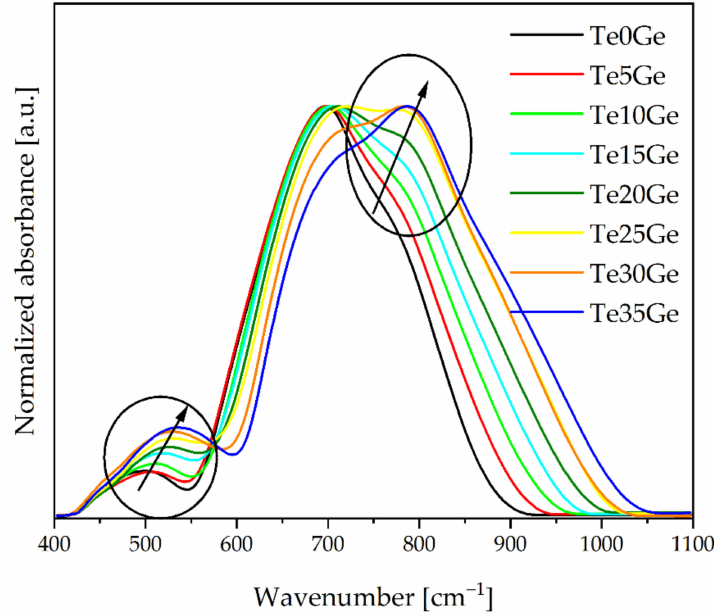
Figure 4. MIR spectra of Eu 3+ -doped glasses with various TeO 2 /GeO 2 molar